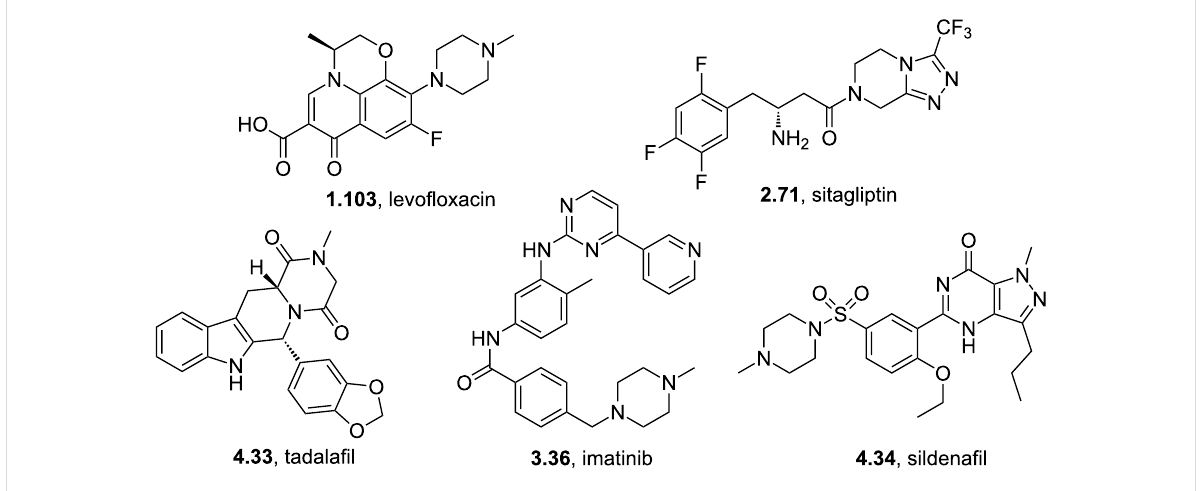
Figure 13: Structures of some prominent piperazine containing drugs.